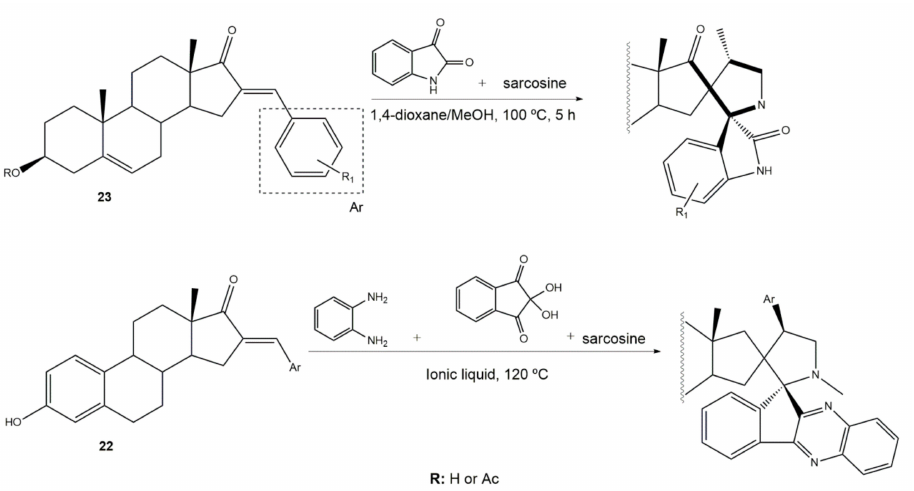
Figure 7. Preparation of steroidal spiro-oxindoles and spiro-pyrrolidines from 16 E -arylidenester- oids